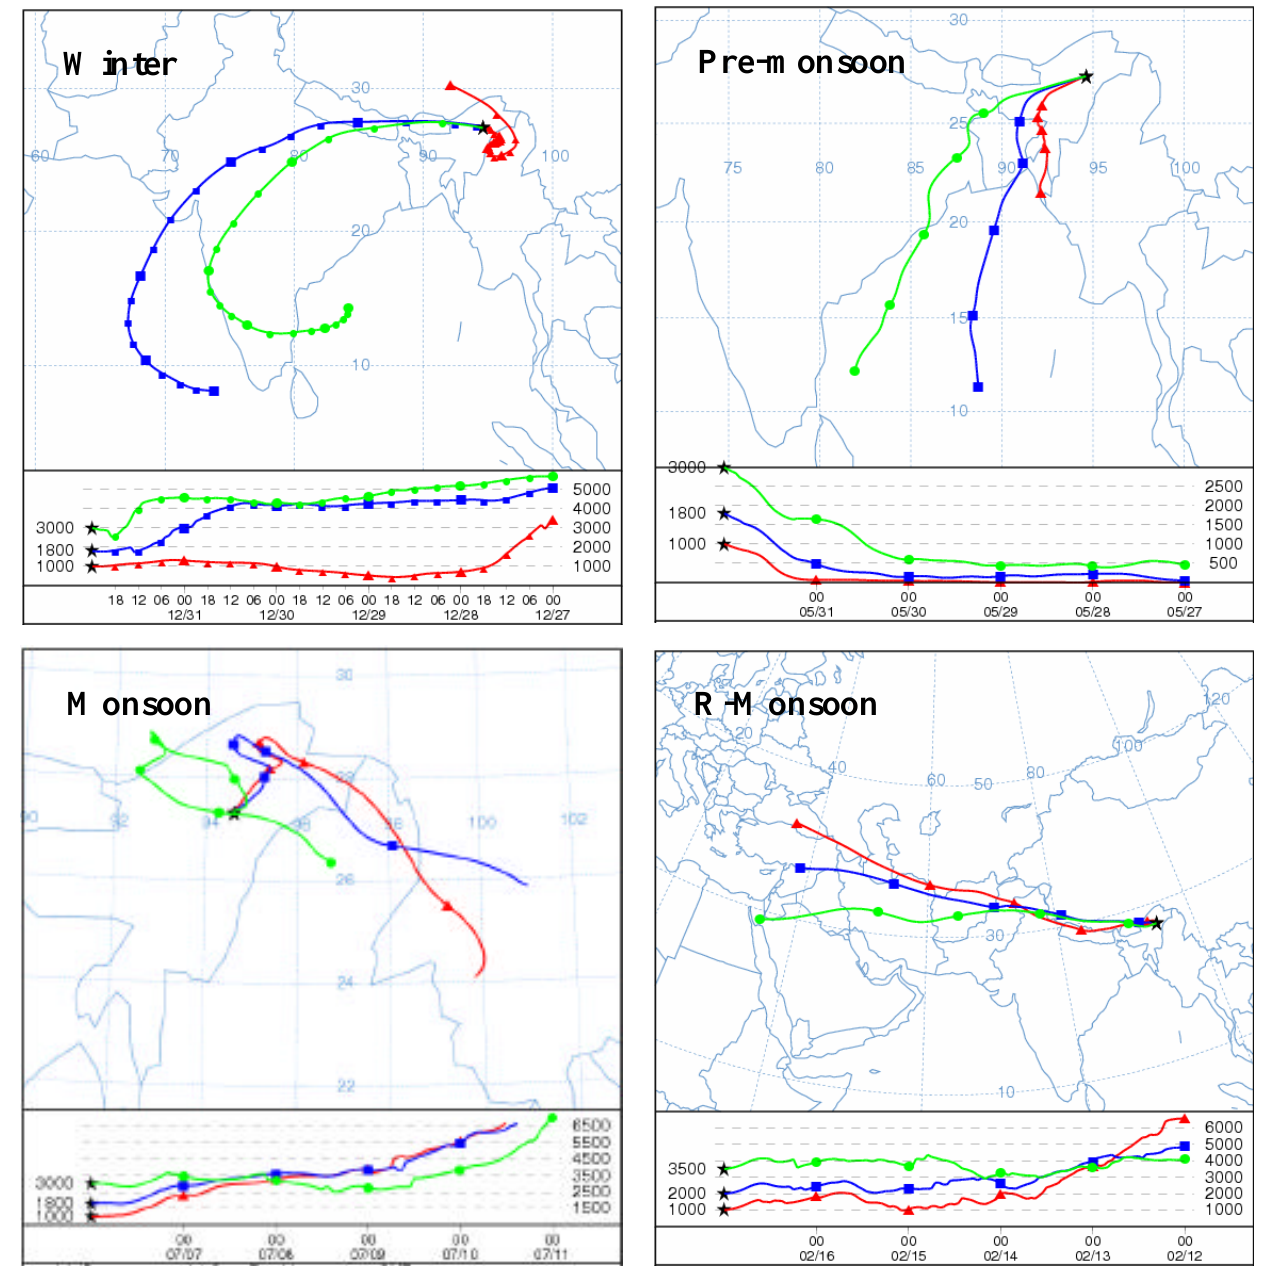
Fig. 11. Examples of five-day back trajectories at 1000, 2000 and 3500m above ground level on four particular days during four different seasons: winter, pre-monsoon, monsoon and Figure 11: Examples of Five-day back trajectories at 1000, 2000 and 3500 m above ground level on four particular days during four different seasons’ winter, pre-monsoon, monsoon and retreating-monsoon.